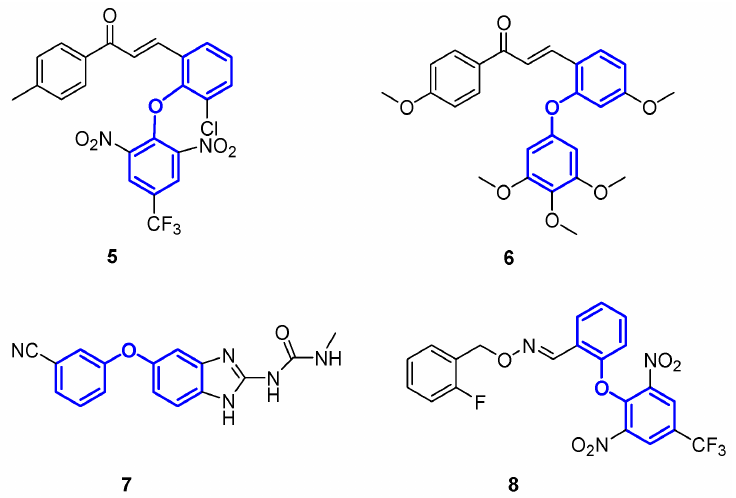
Figure 3. Structures of selected antitubulin agents ( 5 – 8 ) bearing diphenyl ether moieties highlighted in blue.